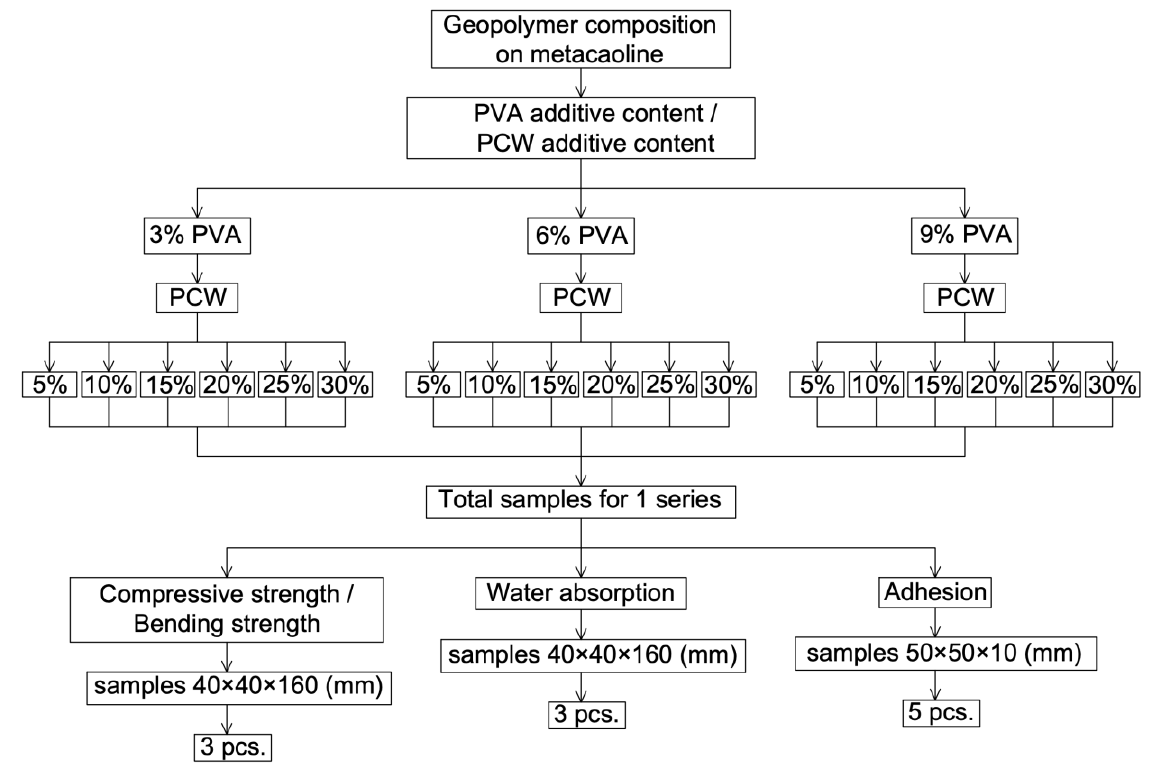
Figure 3. Test plan.